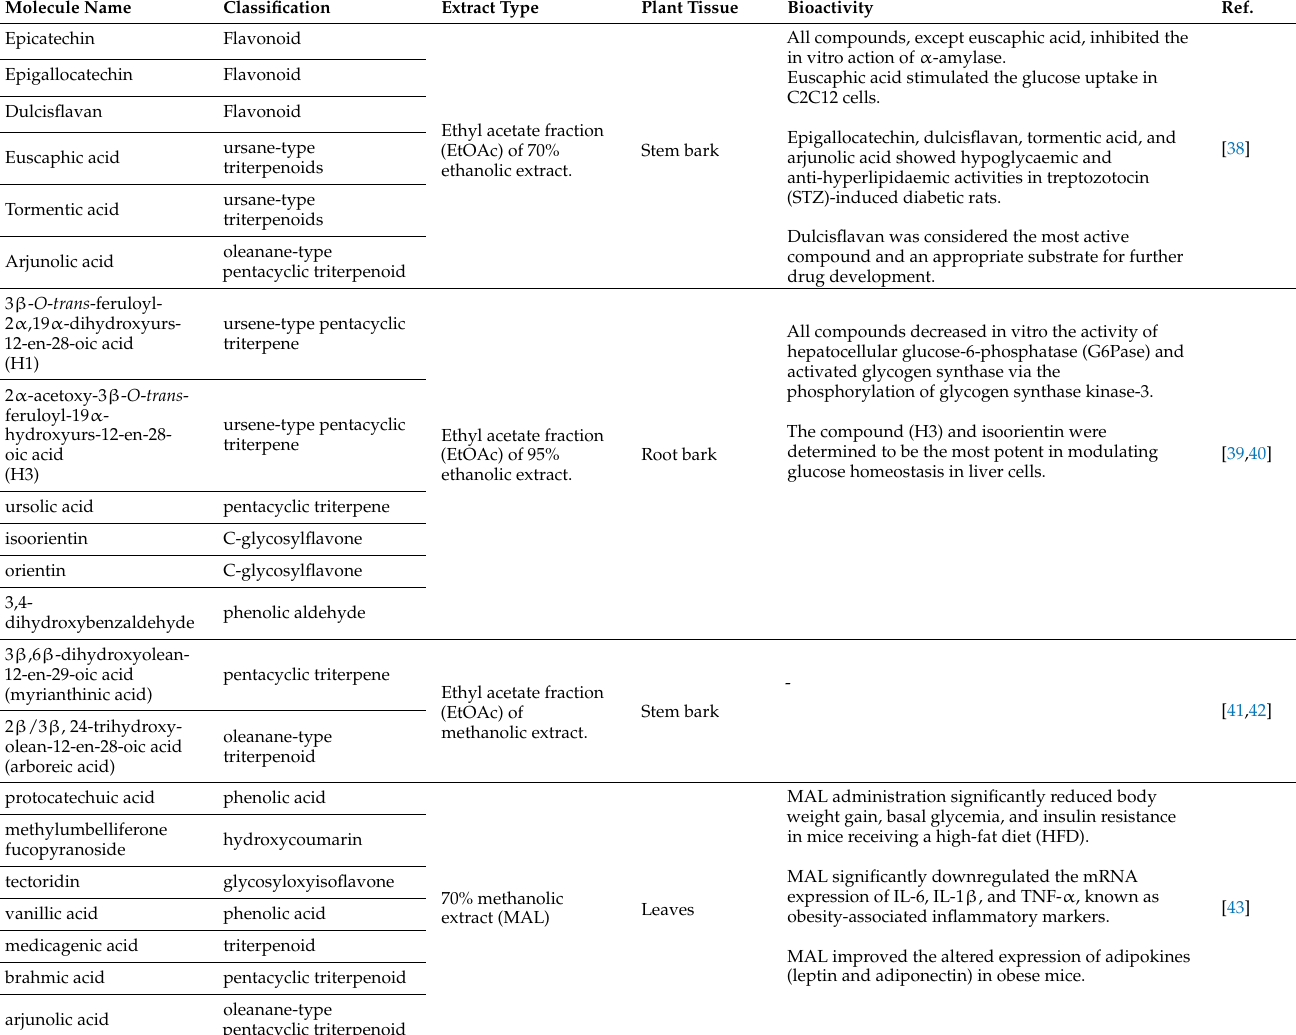
Table 1. Bioactive molecules identified in extracts from forest by-products of M. arboreous